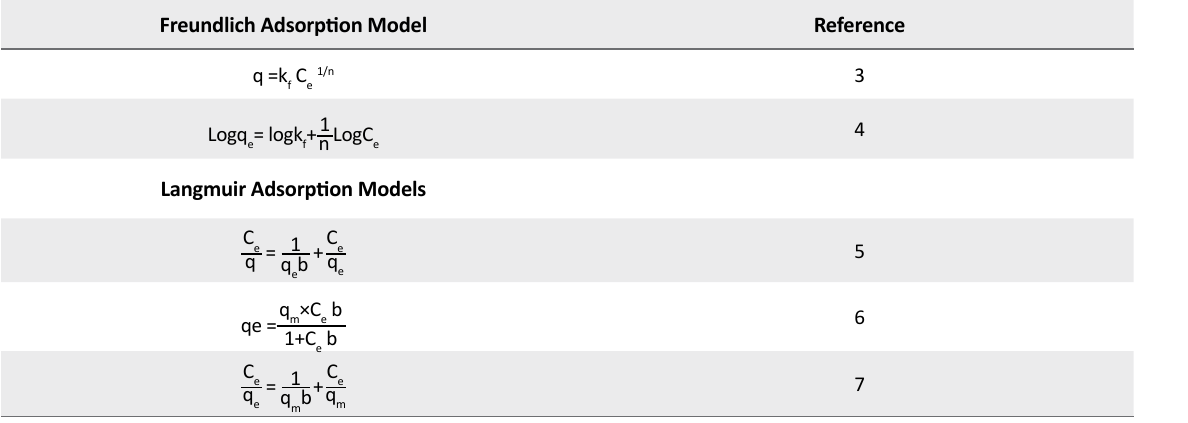
Reference Freundlich Adsorption